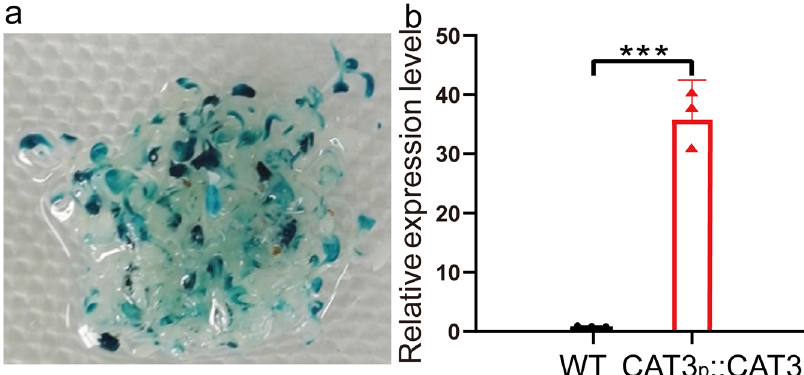
Fig. 5 Determination of the ef fi ciency of transient transformation. a Investigation of the ef fi ciency of transient transformation by GUS staining. The Arabidopsis plants were transiently transformed with pCAMBIA1301. After transformation for 72 h, GUS staining was performed. b Determination of the expression of AtCAT3 gene in the plants transformed with pBI121-ProCAT3:CAT3-GUS. WT: wild-type plants:CAT3p::CAT3:transient transformed plants. The primers for ampli fi cation of AtCAT3 were used in quantitative real-time reverse transcription PCR, and the AtActin3 was used as the internal control. Three replicates (sample size of 50 seedlings) were performed ( n = 3 independent experiments). Error bar indicates standard deviations of the mean measurements. Asterisks indicate highly signi fi cant difference between two samples (*** P < 0.001, t